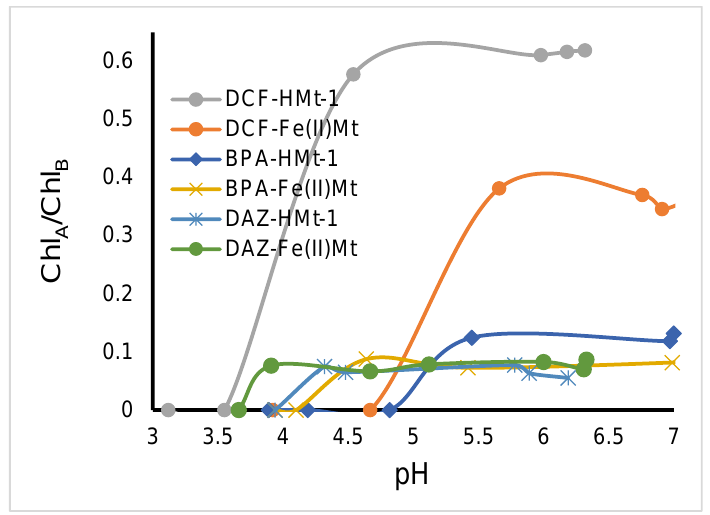
Figure 10. Effect of pH of the ozonized clay-substrate mixtures on chlorophyll A-to-chlorophyll B ratio. The Chl A /Chl B ratio was measured by spectrophotometry at 620 and 665 nm based on Lichten- thaler – Buschman equations. The toxicity tests were achieved i. at constant pH 6.5 adjusted after ozonation and ii. at pH i , the pH of the SIS mixture with the solution of the organic substrate before and after ozonation at different times.